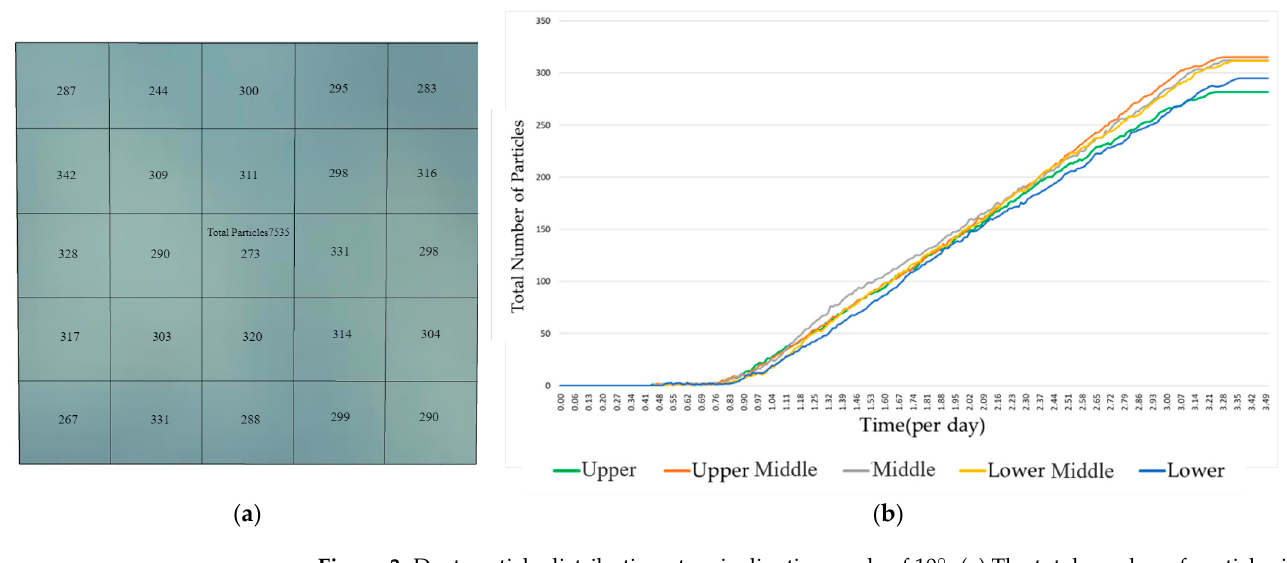
Figure 3. Dust particle distribution at an inclination angle of 10°. ( a ) The total number of particles in each area and ( b ) that over time on the solar panel surface.